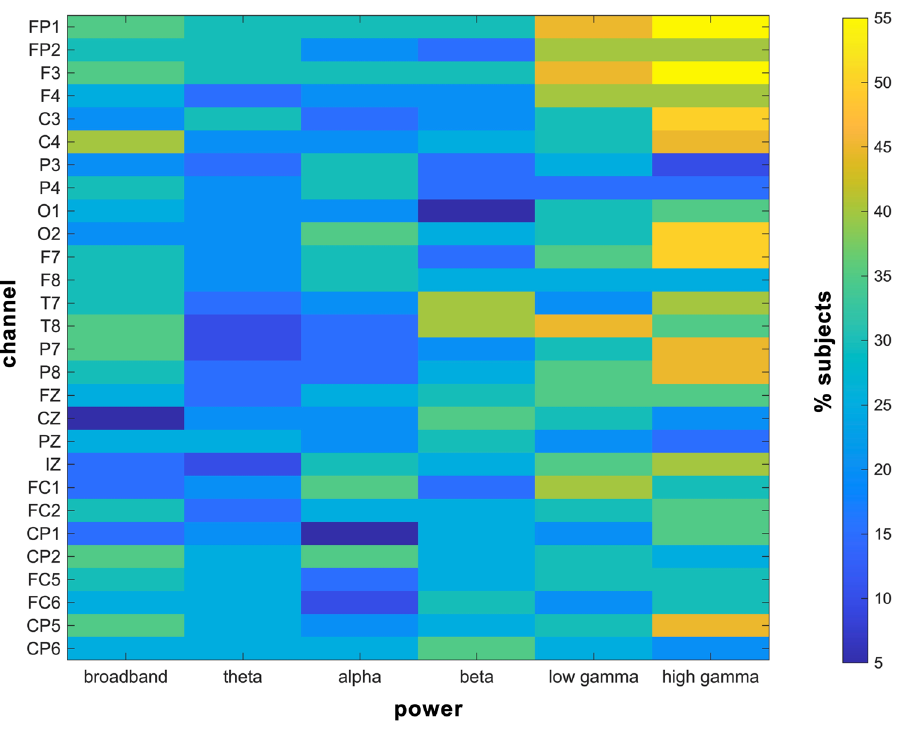
Figure 3. Power spectral features commonly included in each participant’s optimized classifier. Gamma power features across the scalp were included in approximately half of all participants’ final classifiers.